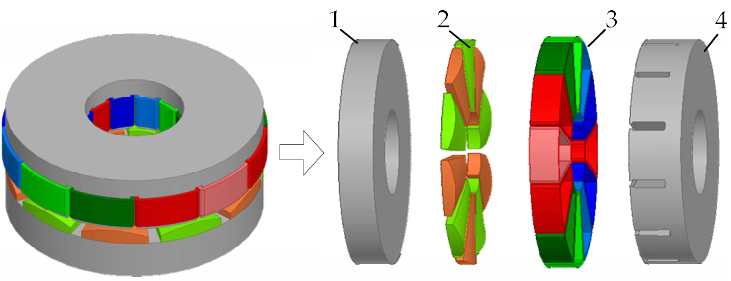
Figure 1. Structure of AFPMBLDCM (1—rotor; 2—permanent magnet; 3—windings; 4—stator).